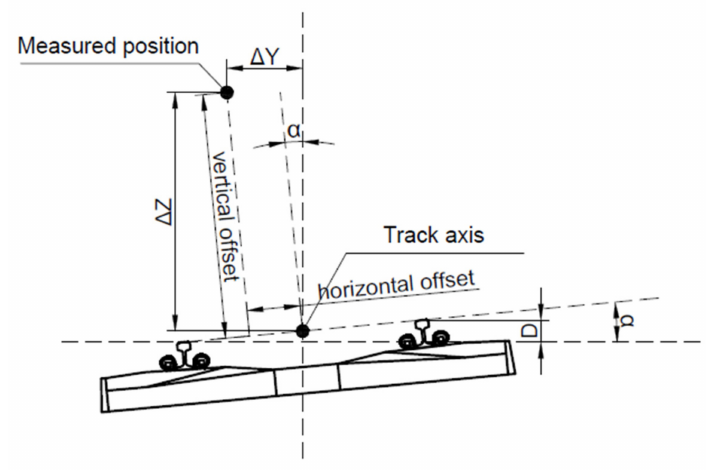
Figure 10. Scheme of offsets of the measured position with respect to